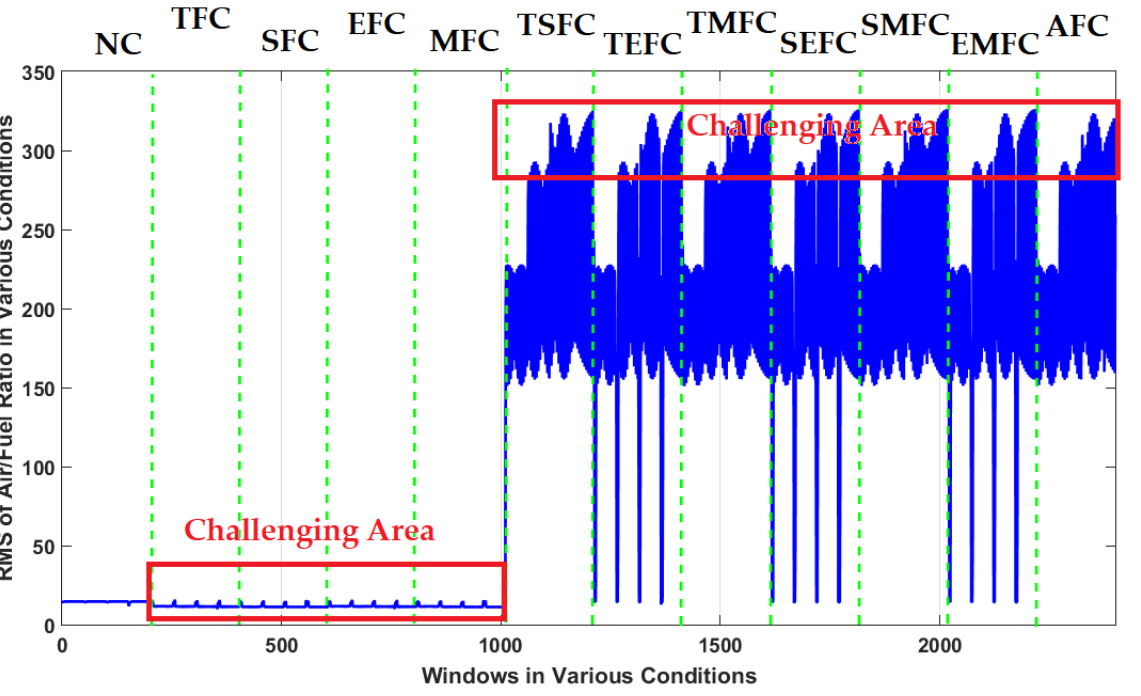
Figure 4. RMS resampled air-to-fuel-ratio signals when sensors operate under normal and abnormal conditions.